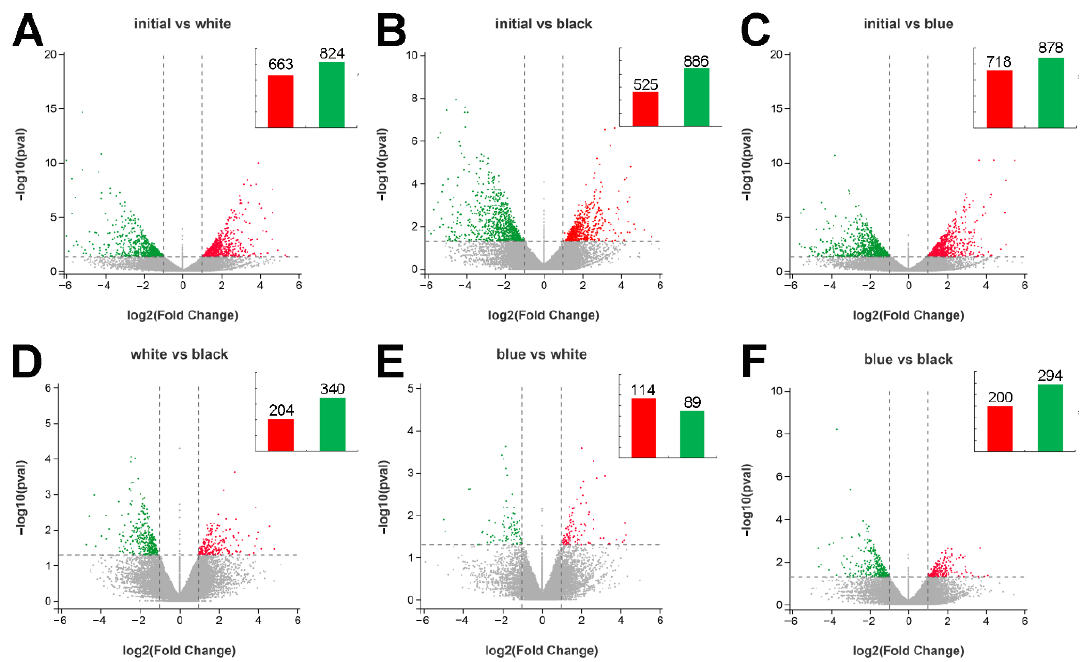
Figure 4. Differentially expressed mRNAs in different groups. ( A ) Volcano plots of initial vs. white. ( B ) Volcano plots of initial vs. black. ( C ) Volcano plots of initial vs. blue. ( D ) Volcano plots of white vs. black. ( E ) Volcano plots of blue vs. white. ( F ) Volcano plots of blue vs. black. Red: upregulated genes; Green: downregulated genes; Grey: no significant differentially expressed genes. We focused on the expression patterns in the four groups and not just the pairwise comparison to identify genes that could be included in P. leopardus skin color darkening.